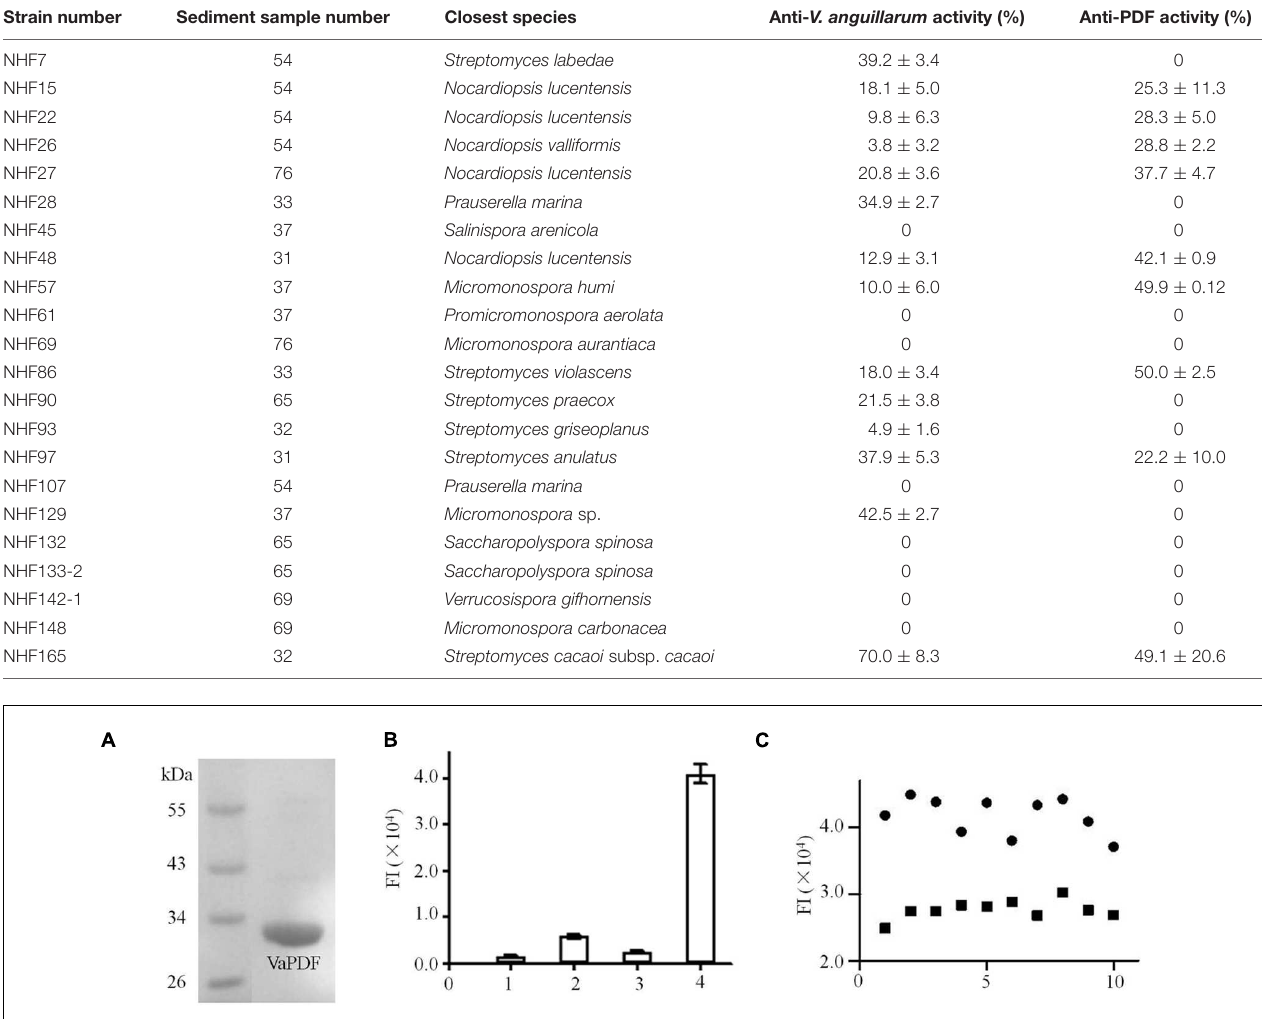
TABLE 1 | Activity assays of marine actinomycetes crude extracts.